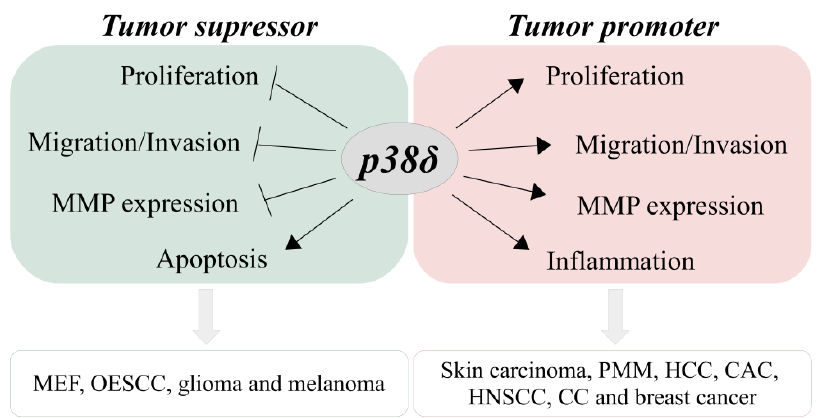
Figure 1. The contrasting roles of p38 δ in cancer. MMP (matrix metalloproteinase), MEF (mouse embryonic fibroblasts), OESCC (oesophageal squamous cell carcinoma), PMM (pleural malignant mesothelioma), HCC, CAC (colitis-associated colorectal cancer), HNSCC, and CC.